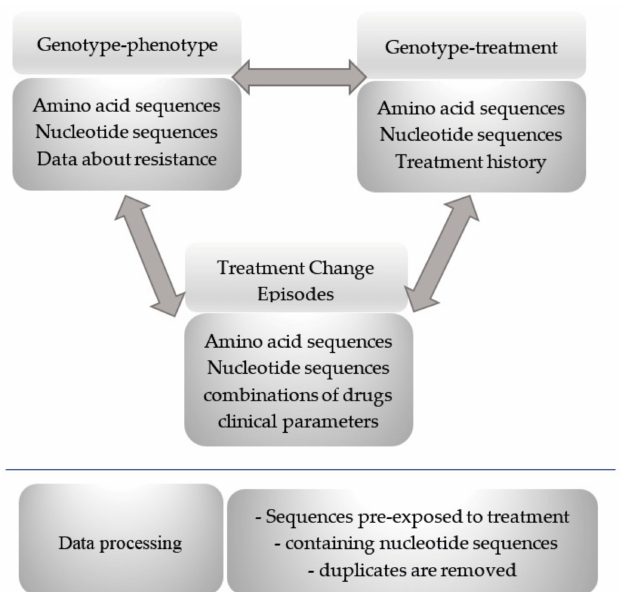
Figure 3. Data processing workflow to compile study datasets. The arrows indicate that this is a certain overlap between three data point types (1) Genotype-phenotype relationship, (2) Genotype-treatment relationship and (3) Treatment Change